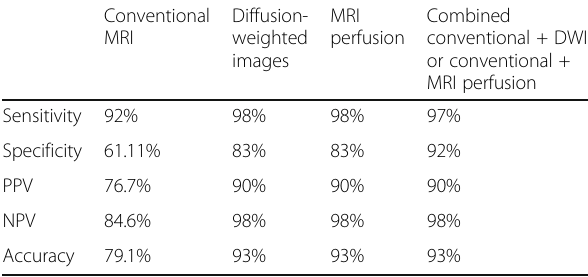
Table 7 ROC curve analysis for prediction of malignancy among various MRI techniques in correlation to the final histopathological